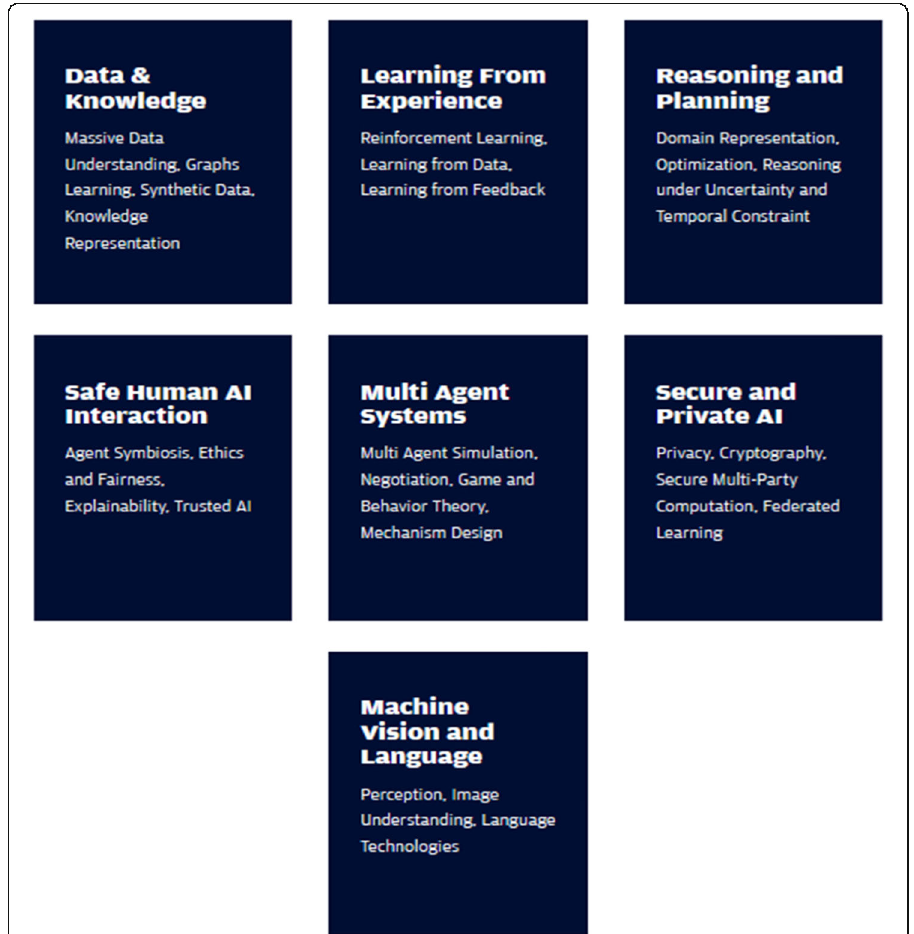
Fig. 1 Artificial intelligence nucleus in business domain (Samsung White Paper,